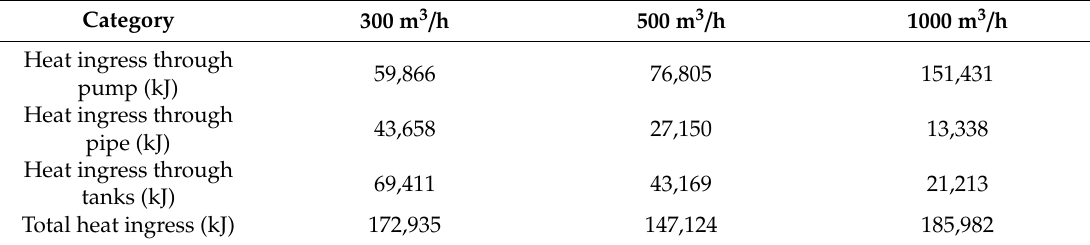
Table 5. Amount of heat ingress at bunkering flow rates of 300, 500, and 1000 m 3 / h.